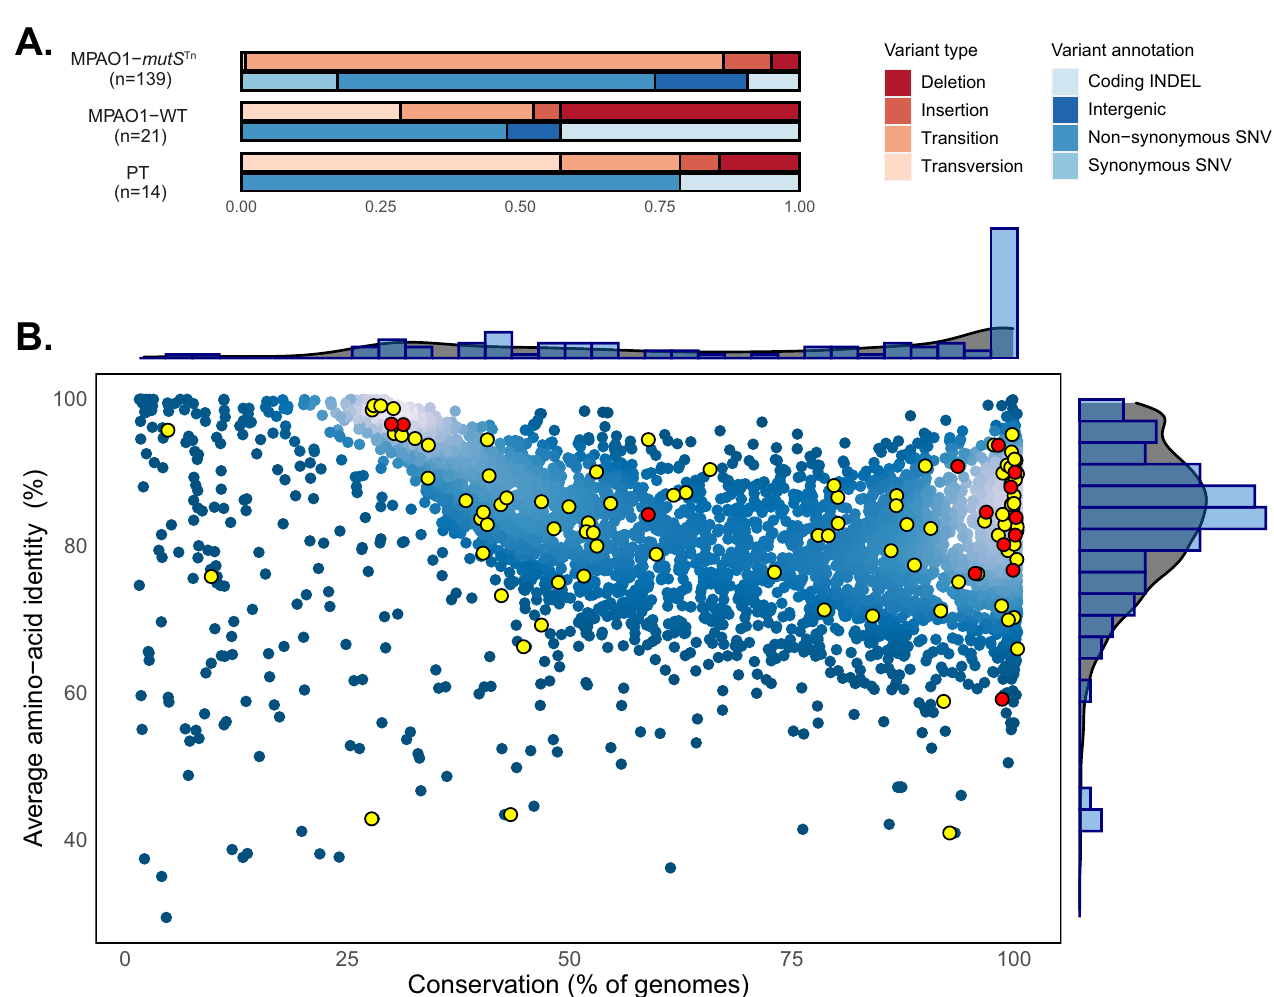
Fig 1. AU : AbbreviationlistshavebeencompiledforthoseusedinFigs 1 (cid:0) 3 andS 10 : Pleaseverifythatallentriesarecorrect : General characteristics of fixed genomic variants that emerged during CZA selection. ( A ) Proportions and types of fixed variants acquired during the course of CZA adaptation for each genotype. The total number of fixed variants acquired across lineages per genotype is indicated in parenthesis. ( B ) Evolutionary conservation of genes with fixed variants acquired in MPAO1- mutS Tn- (yellow) and MPAO1-WT (red) CZA adaptation experiments in the Pseudomonas genus. Each P . aeruginosa PAO1 CDS is plotted as a dot representing average amino acid identity and the proportion of genomes containing the given CDS (breadth of coverage) among a set of 100 complete Pseudomonas genomes (see S6 Data and Methods). Genes without fixed mutation are represented in blue. The marginal density plots and histograms show the distribution of a corresponding conservation measure in all CDSs (gray) and genes containing fixed variants (blue), respectively. The underlying data to generate this figure can be found in S2 Data. CZA, ceftazidime/avibactam; WT, wild type.